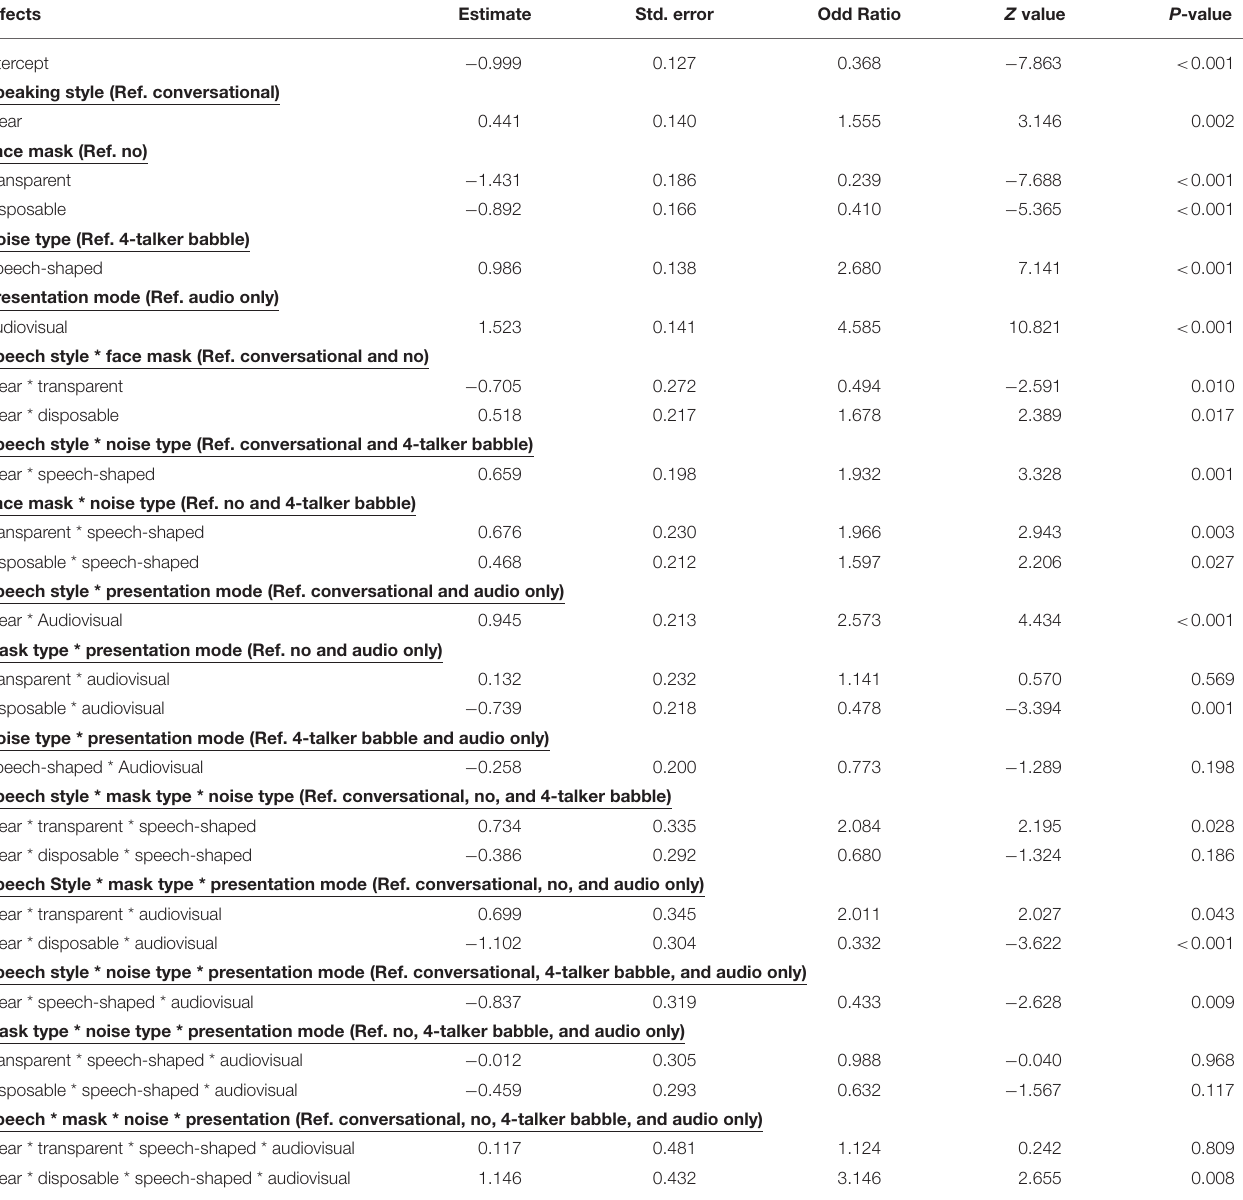
TABLE 2 | Parameter estimates of odds ratio for the main effects and interaction effects of the mixed effects logistic regression model. Effects